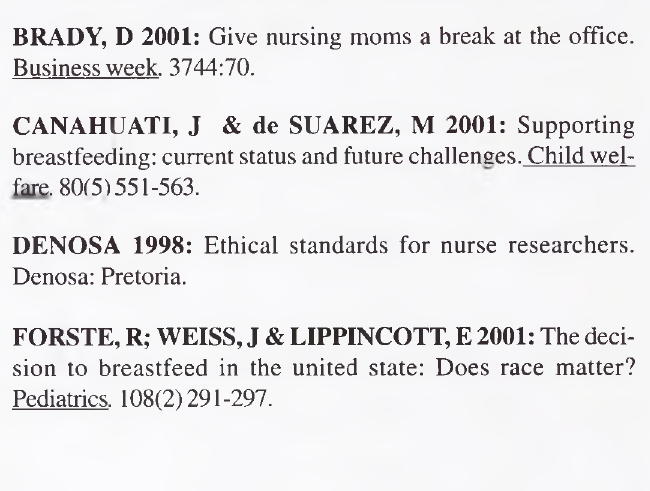
Table 1 : Guidelines for support